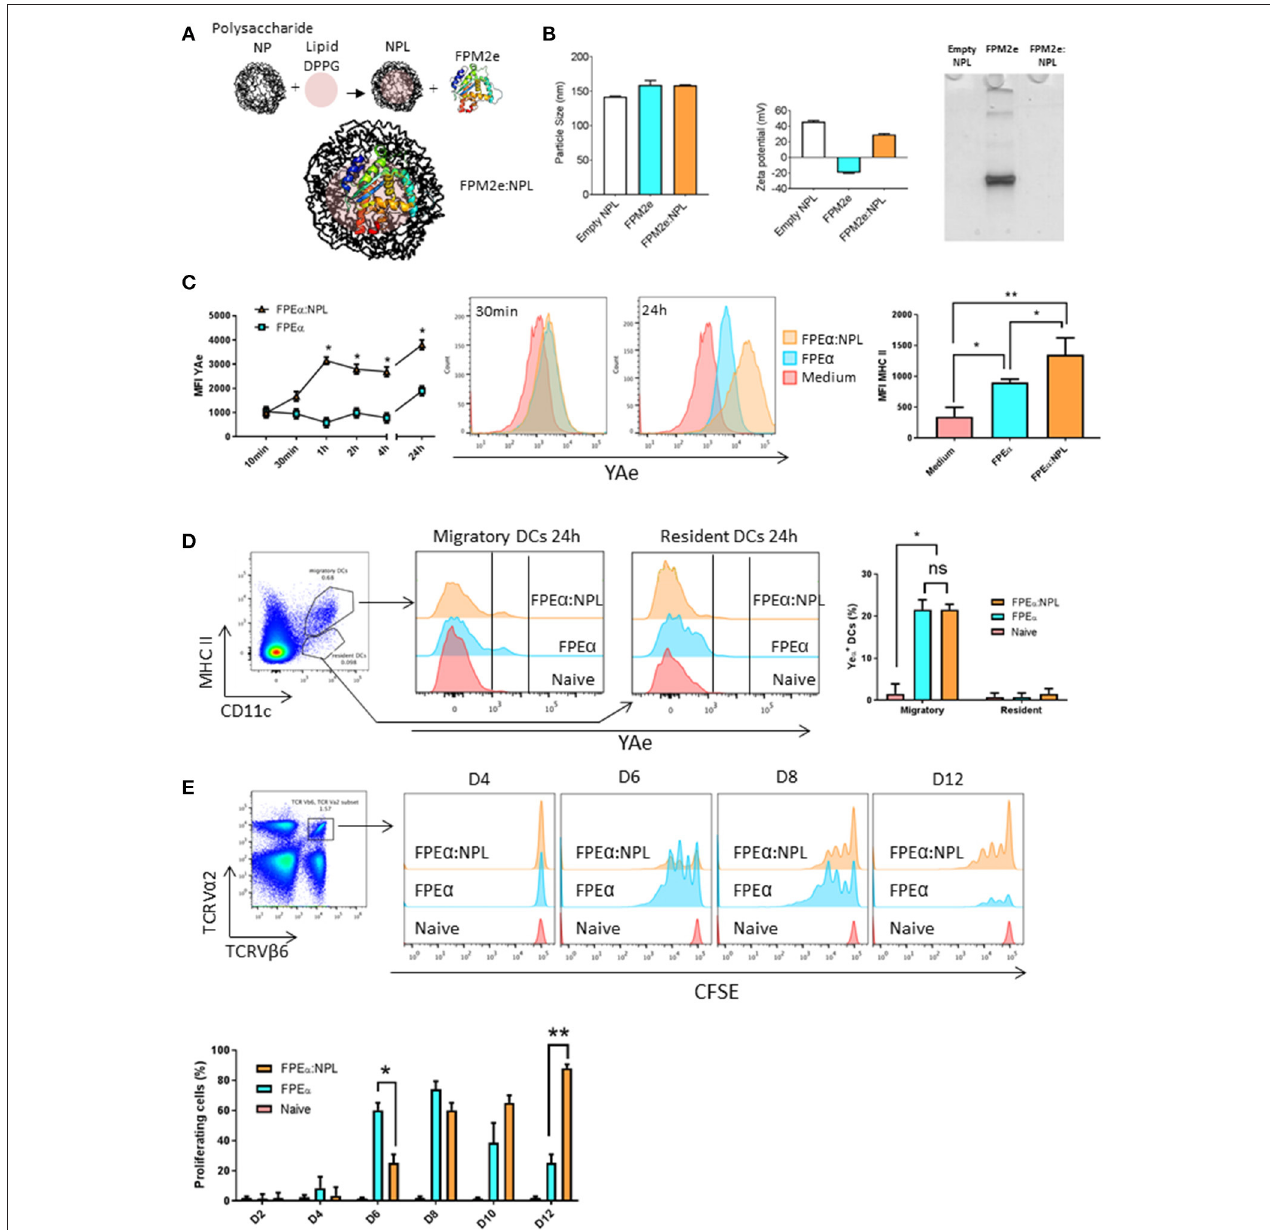
FIGURE 1 | Efficient uptake and presentation of the combined NPL vaccine vector by DCs. (A) Schematic representation of the design of the FPM2e:NPL vaccine vector. (B) FPM2e:NPLs were characterized with regard to particle size (left panel), zeta potential (middle panel) and native-PAGE electrophoresis analysis (right panel). (C) The uptake, processing and surface presentation of E α peptide and MHC class II complexes by D1 dendritic cells (DC) at different time points after stimulation with 0. 2 µ M of FPEa or FPEa:NPL. Surface expression of peptide/MHC II complexes were analyzed by flow cytometry using the mean fluorescent intensity (MFI) of labeled Y-Ae Mab plotted as means ± SD of 3 experiments (left panel). Representative histograms of Y-Ae MFI after 30min and 24h stimulation are shown (middle panel). MFI values of anti-MHC II Mab labeling of the D1 cell surface after stimulation with FPEa or FPEa:NPL are given as means ± SD of 3 experiments (right panel). (D) Gating strategy used for migratory and resident DCs in the mediastinal lymph node (mLN) (left panel). Representative FACS histograms of Y-Ae MFI in migratory (MHC II high , CD11c + ) and resident (MHC II low , CD11c + ) DCs 24h after a single i.n immunization (middle panel). The percentage of Y-Ae + cells in migratory and resident DC populations was calculated in 3 independent experiments and given as means ± SD (right panel). (E) Gating strategy used to identify proliferation in E α -specific CFSE-labeled TCR Tg CD4 + T cells following i.n immunization (left panel). Representative FACS histograms of proliferating TCRV α 2 + TCRV β 6 + CFSE + T cells in the mLN at 4, 6, 8, and 12 days after a single i.n immunization with 5 µ g of FPE α or FPE α :NPL in C57Bl/6 mice adoptively transferred on day 0 with 2 × 10 6 TCRV α 2 + TCRV β 6 + CFSE + CD4 + T cells (right panel). The percentage of proliferating TCRV α 2 + TCRV β 6 + CFSE + CD4 + T cells was calculated and given as means ± SD (lower panel). These data are from at least 3 independent experiments giving similar results. Statistical significance was calculated by unpaired t -test and p -values are given as * p < 0.05 and ** p < 0.01.